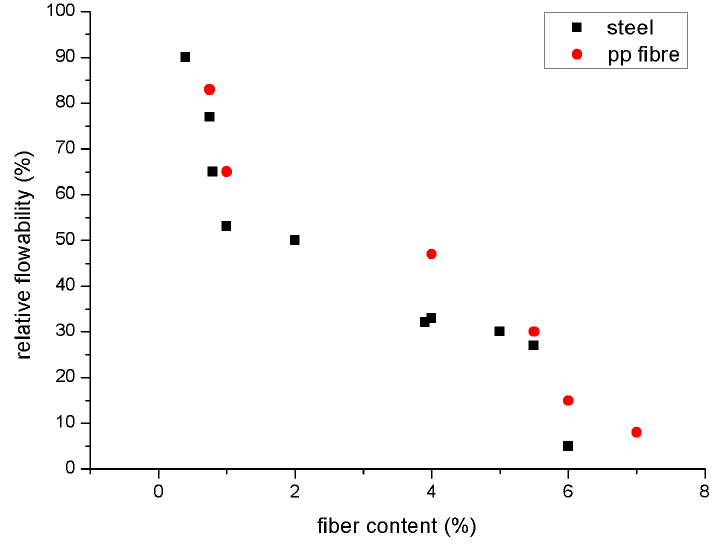
Figure 11. Relative flowability [76].